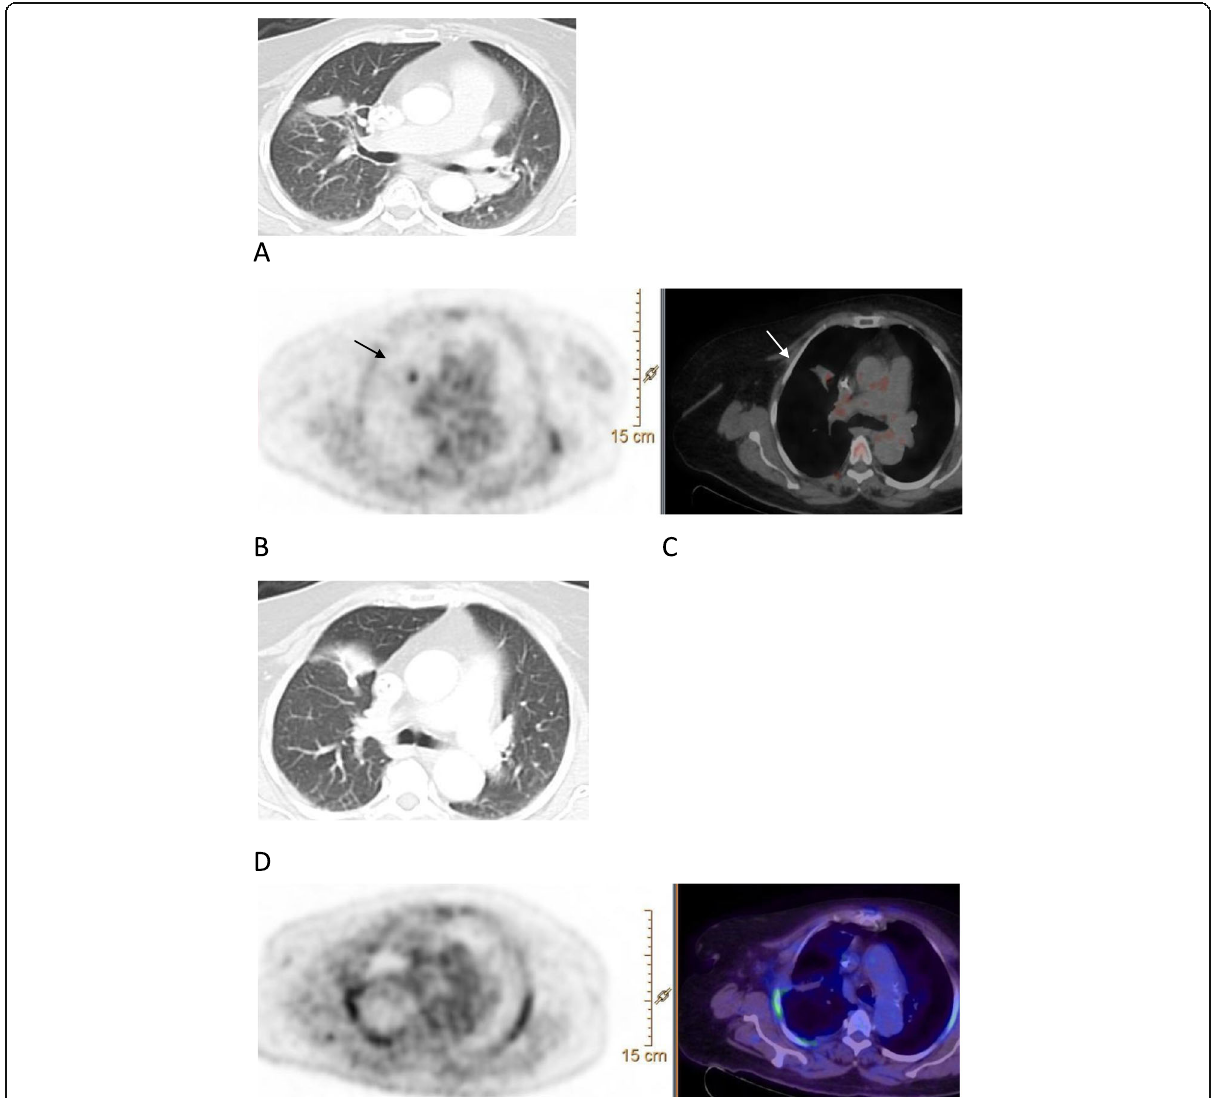
Fig. 6 A 70-year-old female patient who underwent colonic mass surgical resection for pathologically proven adenocarcinoma, presented 4 months later by elevated tumor markers. a Axial CT image in lung window showing right upper lobe pulmonary nodule. b Axial PET attenuated corrected image and axial fused PET – CT image of right upper lobe metabolically active nodule (arrows). c Post-radiofrequency ablation assessment for the pulmonary nodule by contrast-enhanced CT showed stationary size depending on the size criteria (appreciable change in size needs time). d PET – CT revealed a photopenic area corresponding to the ablated nodule with no metabolically active lesion